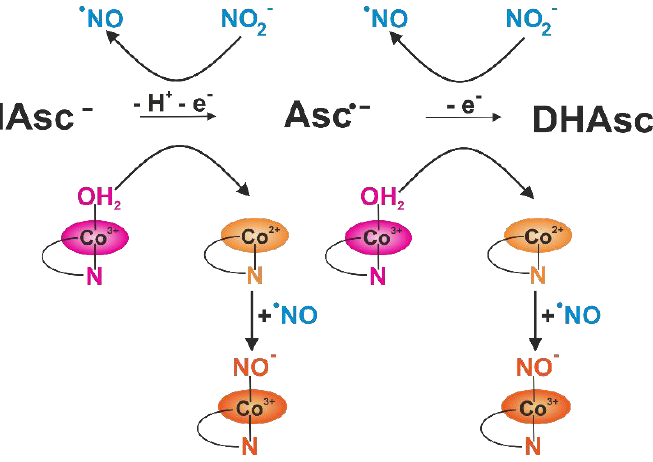
Figure 5. Plot of observed rate constant (k obs ) versus concentration of Krakow winter ( a ) and Krakow summer ( b ) dust for the reaction between CblNO 2 (8.6 × 10 −5 M) and Asc (1.7 × 10 −3 M) at pH 4.3 (25.0 °C, acetate buffer) during the formation of CblNO. The data point at zero Krakow dust concentration is the reference value in the absence of any nanoparticles.